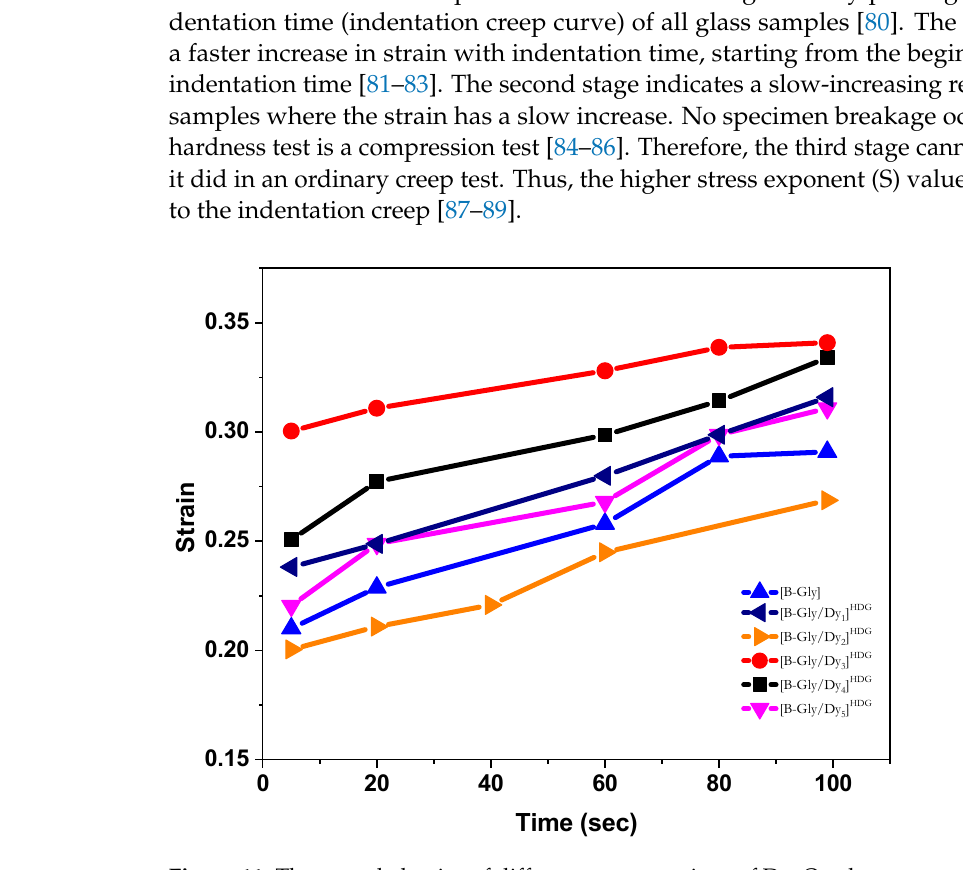
Figure 11. The creep behavior of different concentrations of Dy 2 O 3 glass